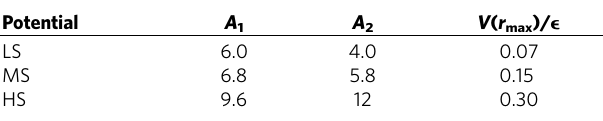
Table 1 | Potential